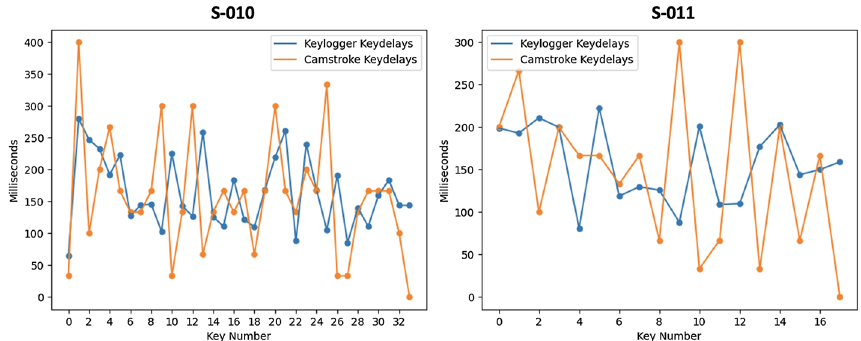
Fig. 13 Poor KeyDelay comparison for greeting sentence sample